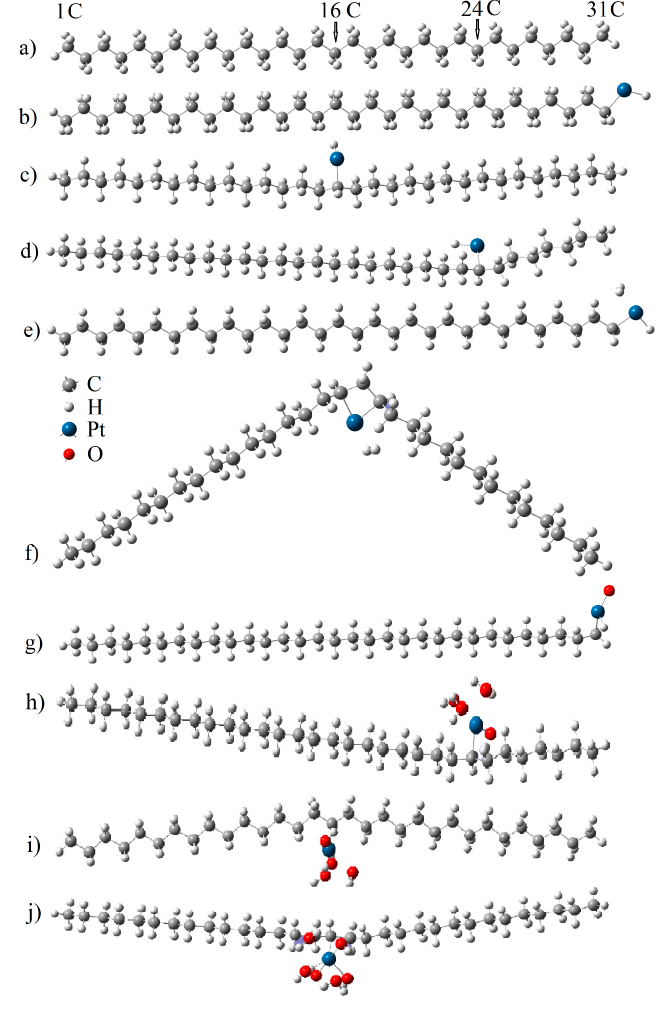
Figure 6. C 31 molecules fabricated using the AMPAC 10 program [31]. The first, 16th (central), 24th (¾ position) and the 31st carbon atoms are labelled 1C, 16C, 24C and 31C respectively. ( a ) C 31 H 64 , ( b ) C 31 H 64 with Pt at end, attached to 31 C, ( c ) C 31 H 64 with Pt at centre, attached to 16 C, ( d ) C 31 H 64 with Pt at ¾, attached to 24 C, ( e ) C 31 H 64 with tetrahedrally coordinated Pt at end attached to 31 C, ( f ) C 31 H 64 with tetrahedrally coordinated Pt at centre attached to 16 C, ( g ) C 31 H 64 with PtOH at end, attached to 31 C, ( h ) C 31 H 64 with Pt(H 2 O) 2 (OH) 2 at ¾, attached to 24 C, ( i ) C 31 H 64 with Pt(H 2 O) 2 (OH) 2 at centre, attached to 16 C, ( j ) C 31 H 64 with Pt(H 2 O) 2 (OH) 4 at centre, attached to 16 C.